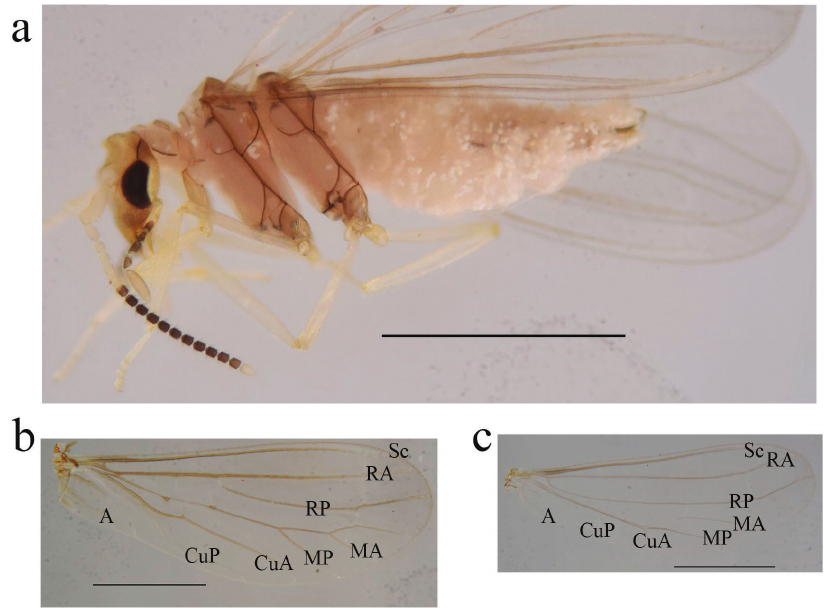
Figure 3. Heteroconis terminalis (Banks, 1913), male from Guangxi (China) a habitus, lateral view b head, dorsal view c forewing d hindwing. Scale bar: 1 mm.